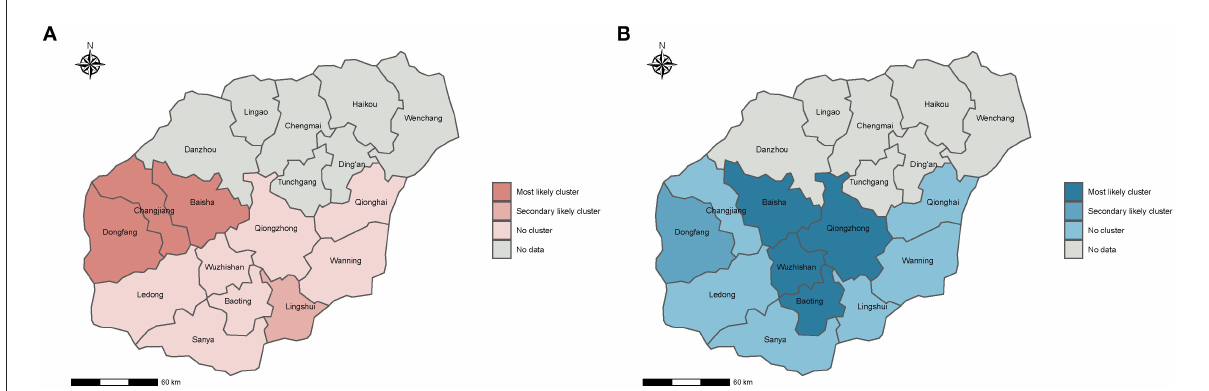
FIGURE1 Spatial distribution of clusters with high G6PDd risk and high malaria risk in Hainan, China, 2009–2011. (A,B) is the spatial distribution of clusters with high G6PDd risk and high malaria risk, respectively. The risk of G6PDd and malaria were ordered using the likelihood ratio (LLR). The most likely cluster indicates the area with the highest risk of G6PDd and malaria, and the secondary likely cluster indicates the area with the second highest risk of G6PDd and